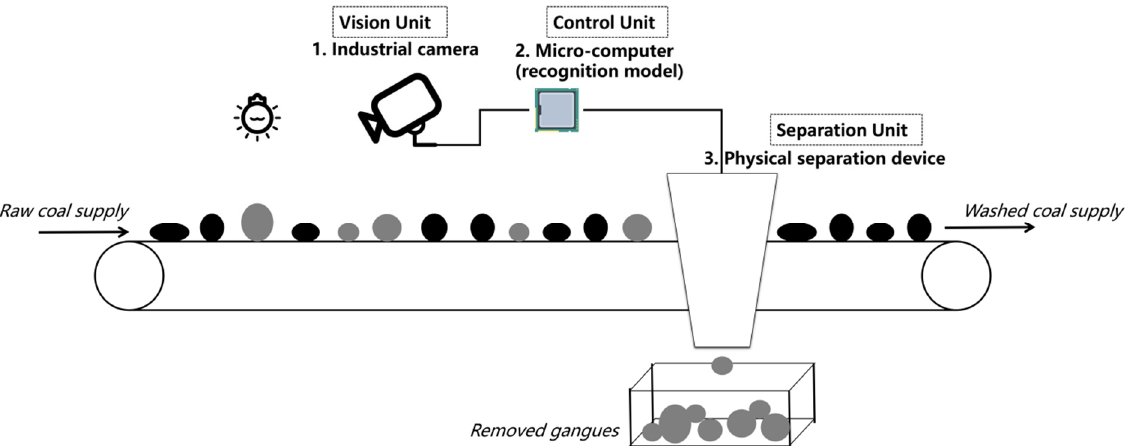
Figure 1. General framework of automated vision-based coal and gangue separation system. An example of a physical separation device is a robot with picking end-effector, e.g., gripers.